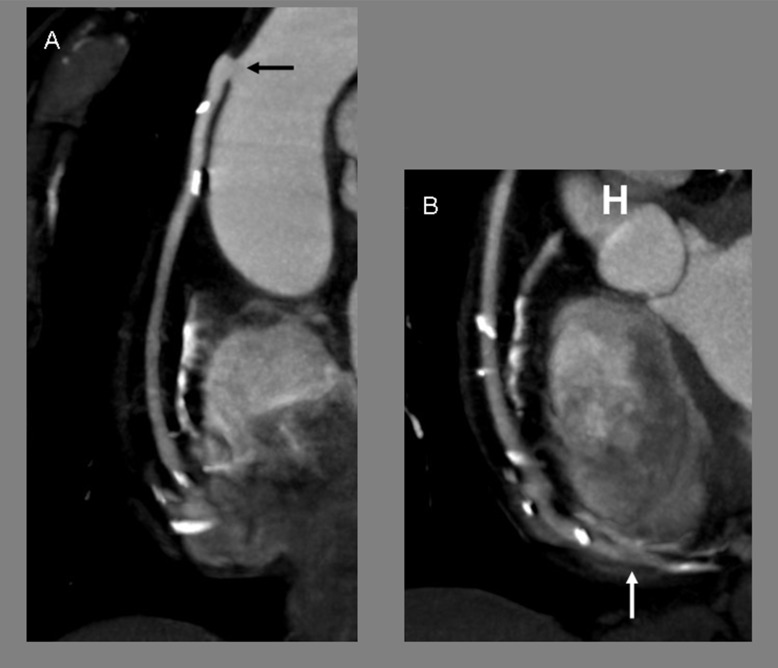
Coronary artery bypass graft – Significant cardiac motion artifacts.256-slice MDCT with prospective ECG-gating, curve reformat (A, B), of a 79-yo woman with a sequential aortocoronary saphenous vein graft to the distal right coronary artery, and then to the first marginal artery of the circumflex artery. A, B: the first graft sequence is shown, from the lateroterminal proximal anastomosis (black arrow) on the ascending aorta, to the laterolateral distal anastomosis (white arrow) on distal right coronary artery. The scores for image quality in proximal, middle and distal graft segments were 5 (excellent), 3 (moderate) and 3, respectively, for both 2 independent observers. Mean heart rate was 65 bpm. Heart variability (standard deviation of heart rate) was 4.9 bpm.